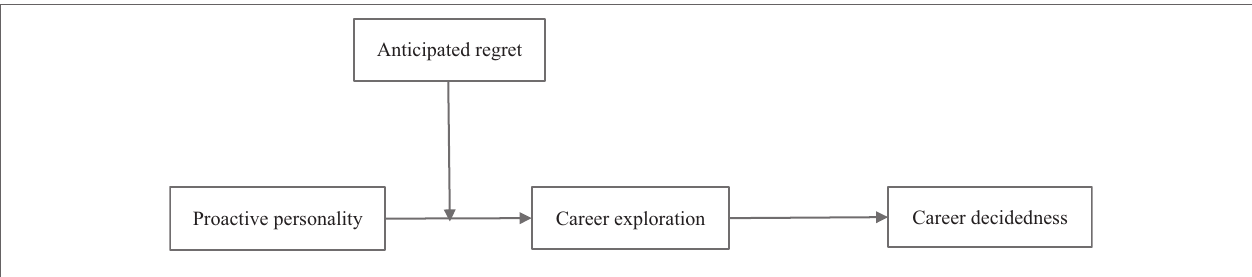
FIGURE 1 | Proposed model of the